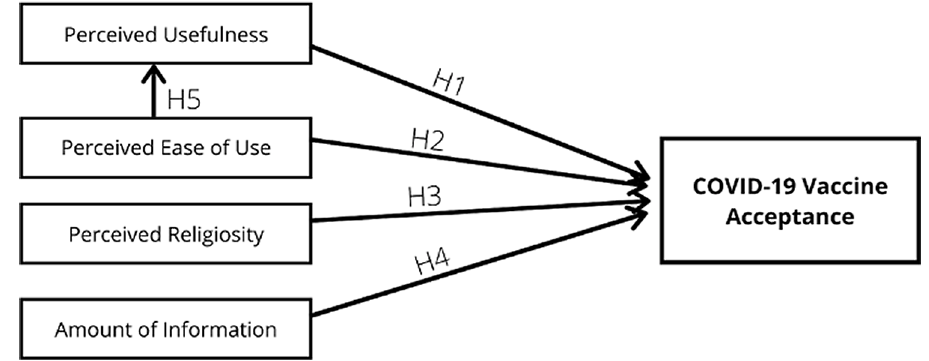
Figure 1. Proposed model of the relationship of perceived usefulness, perceived ease of use, perceived religiosity, and amount of information on COVID-19 on vaccine acceptance.